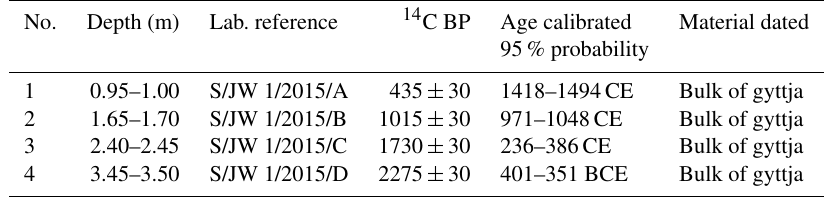
Table 1. List of radiocarbon determinations.